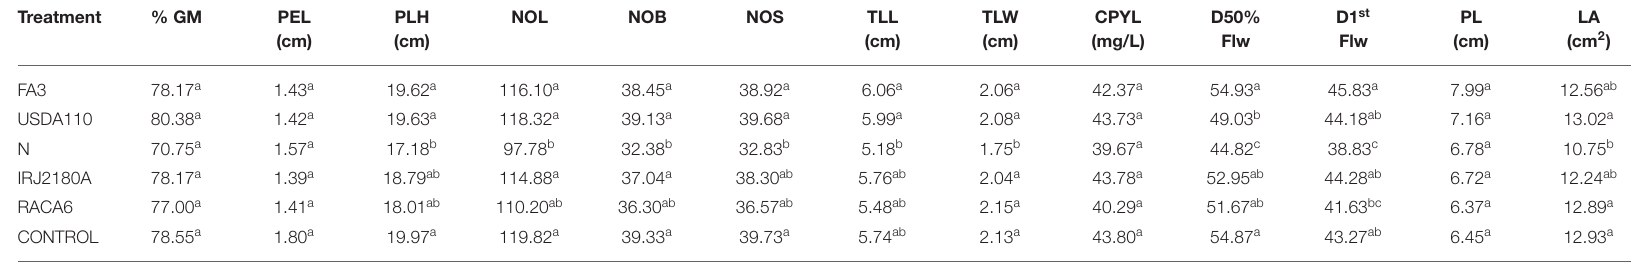
TABLE 4 | Effect of N fertilizer and B. japonicum strains on the percentage of germination at 2 WAP, growth traits of accessions of Bambara groundnut at 7 WAP, and flowering in Ibadan and Ikenne in the second season, 2020. Treatment